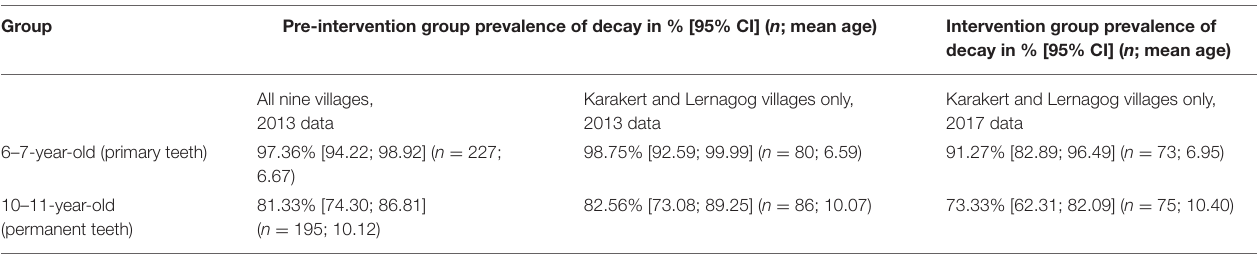
TABLE 1 | Prevalence of caries pre-intervention and 4 years after the start of the program.